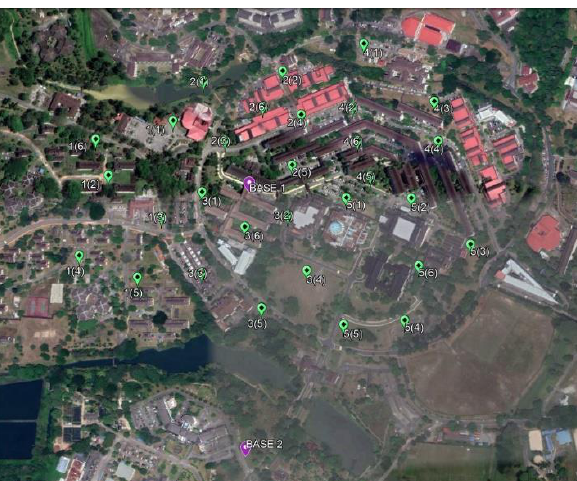
Figure 1 . GPS observation point